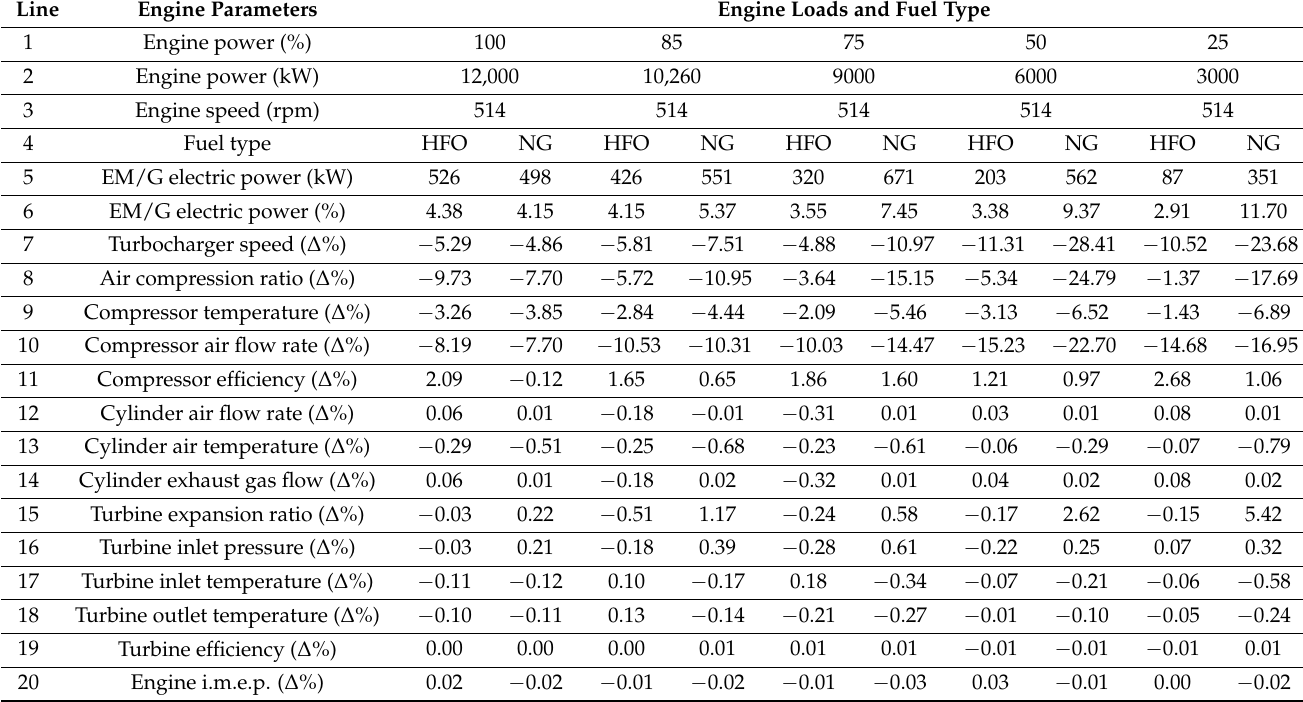
Table 3. TC and HTC comparison for different fuels and engine working points at constant speed.